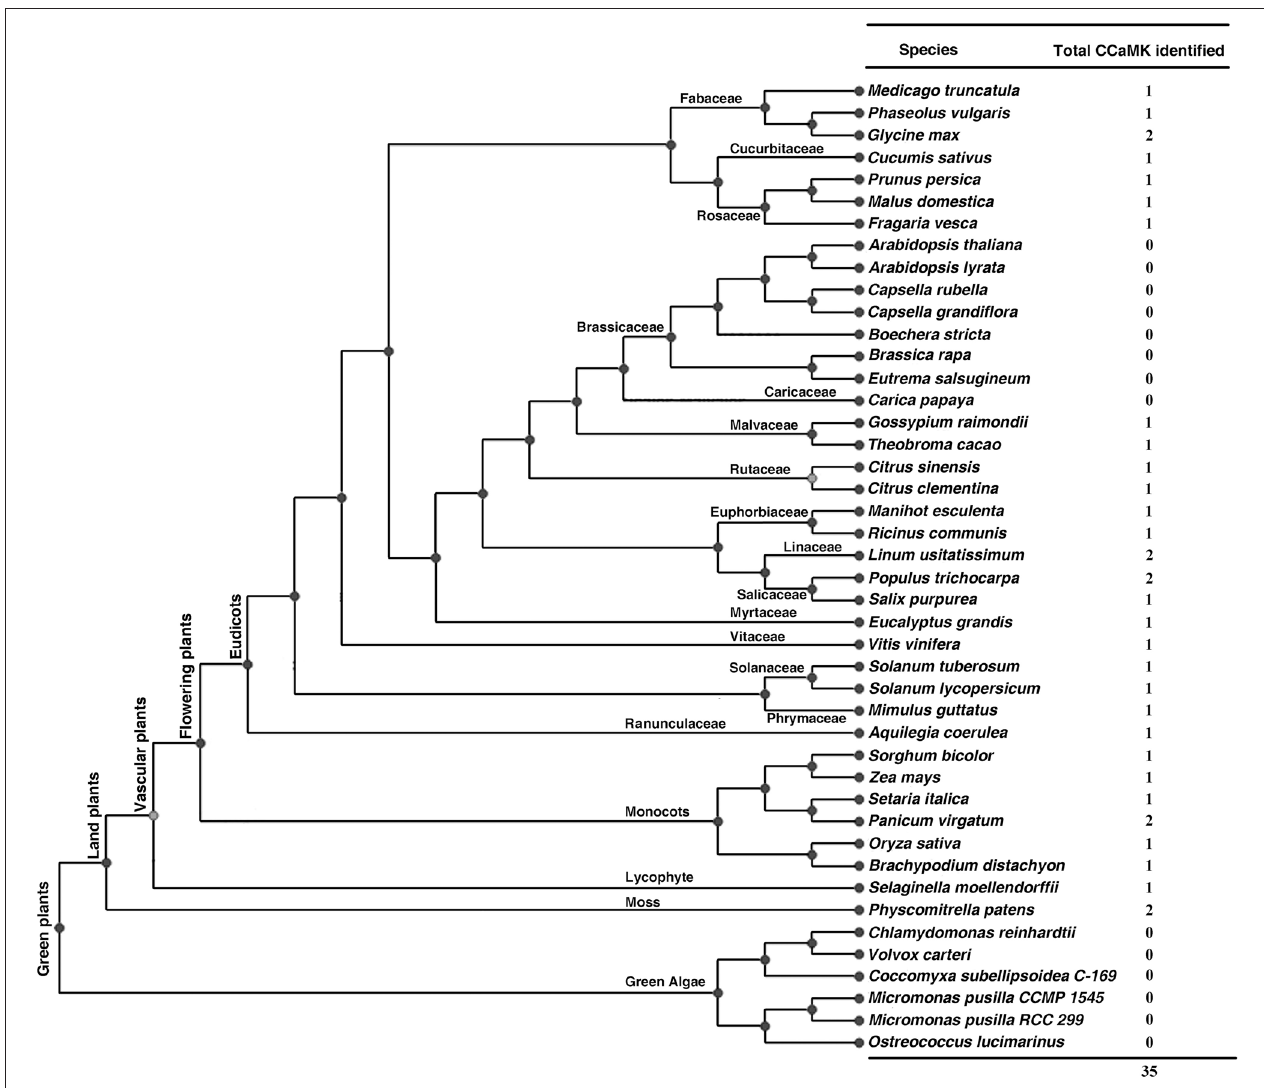
FIGURE 1 | CCaMKs identified in 44 plant species whose genome sequence data are deposited in Phytozome. Phylogenetic tree for the plant species is adapted from the Phytozome database (http://phytozome.jgi.doe.gov/pz/portal.html).